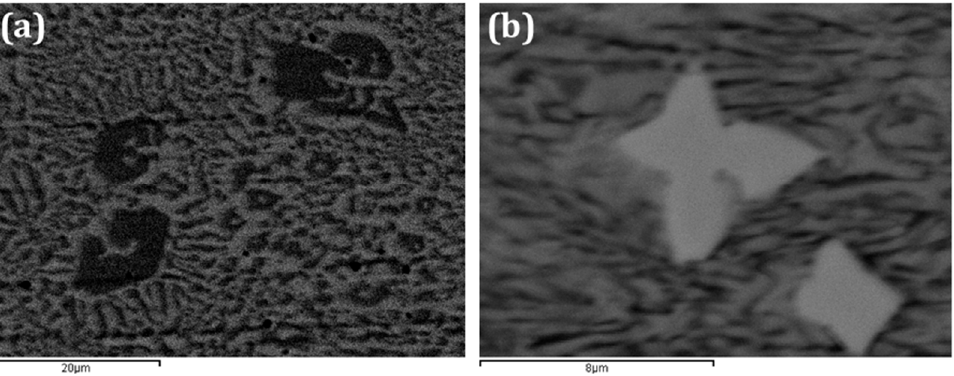
Figure 10. SEM micrographs of primary ( a ) chromium and ( b ) niobium carbides formed on an AISI 4130 steel via arc welding technique.